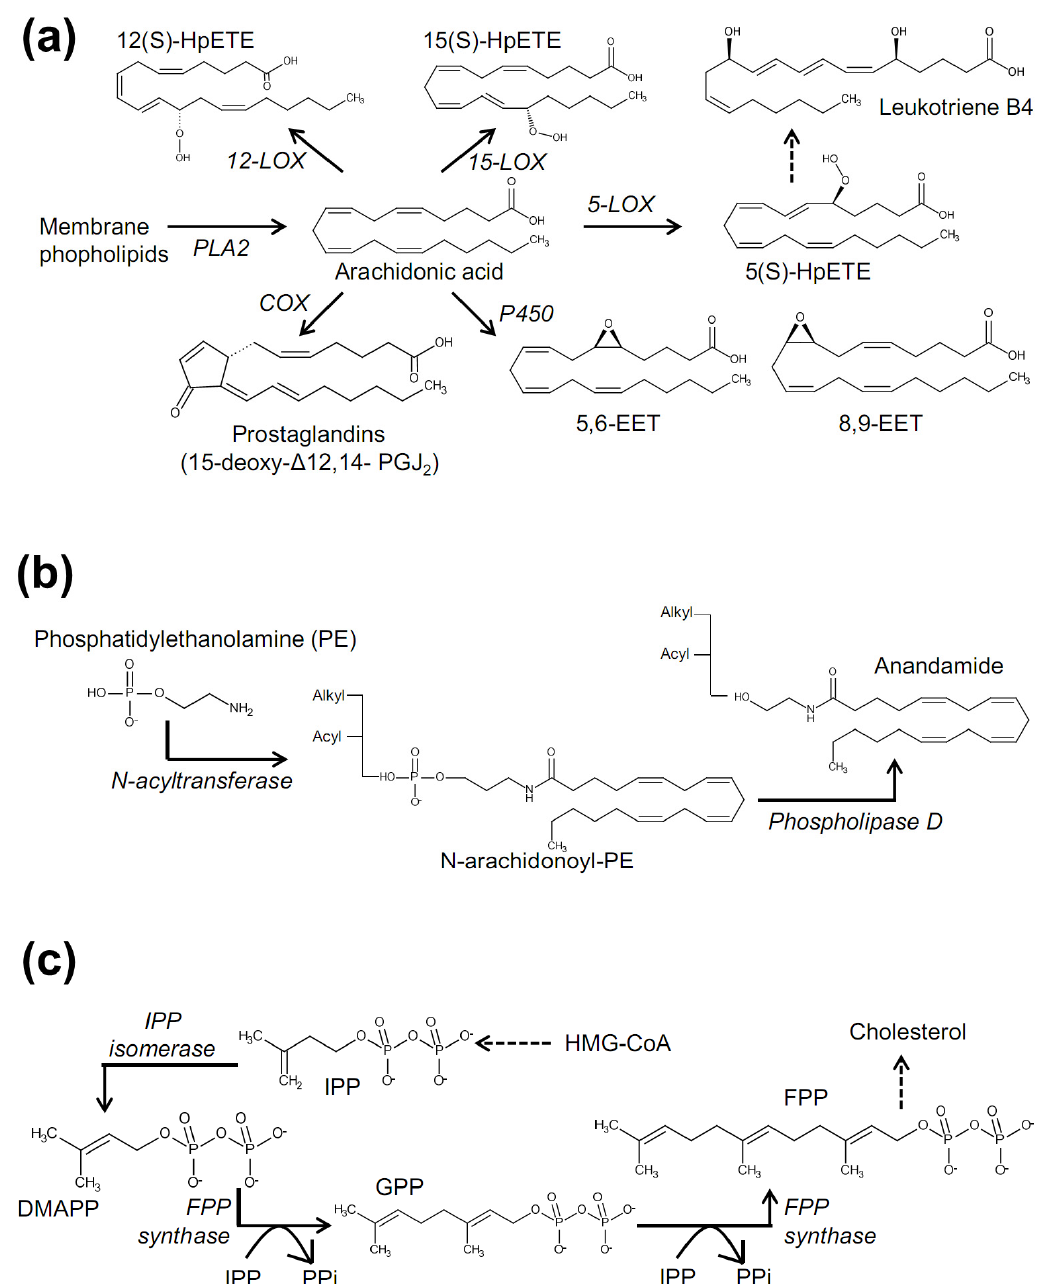
Figure 3. Biosynthetic pathways for HpETEs, EETs ( a ); anandamide ( b ); and isoprenoids ( c ), that are known to regulate activities of sensory TRP